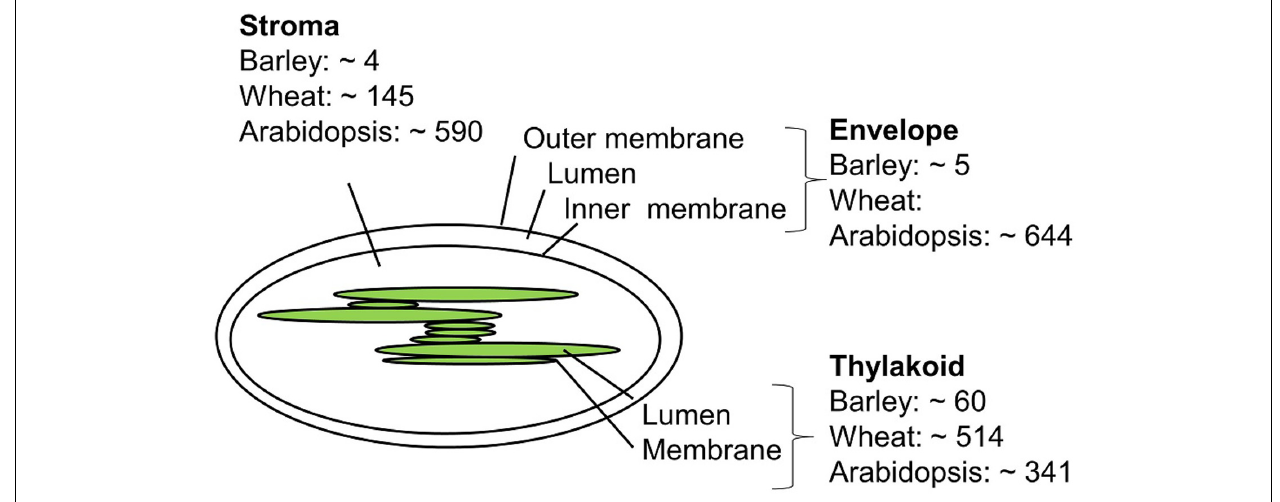
FIGURE 2 |Approximate number of chloroplast proteins identified in barley (Ciambella etal., 2005; Bartsch etal., 2008; Ploscher etal., 2011), wheat (Kamal etal., 2012), and Arabidopsis (Peltier etal., 2004; Giacomelli etal., 2006; Zybailov etal., 2008; Ferro etal., 2010).